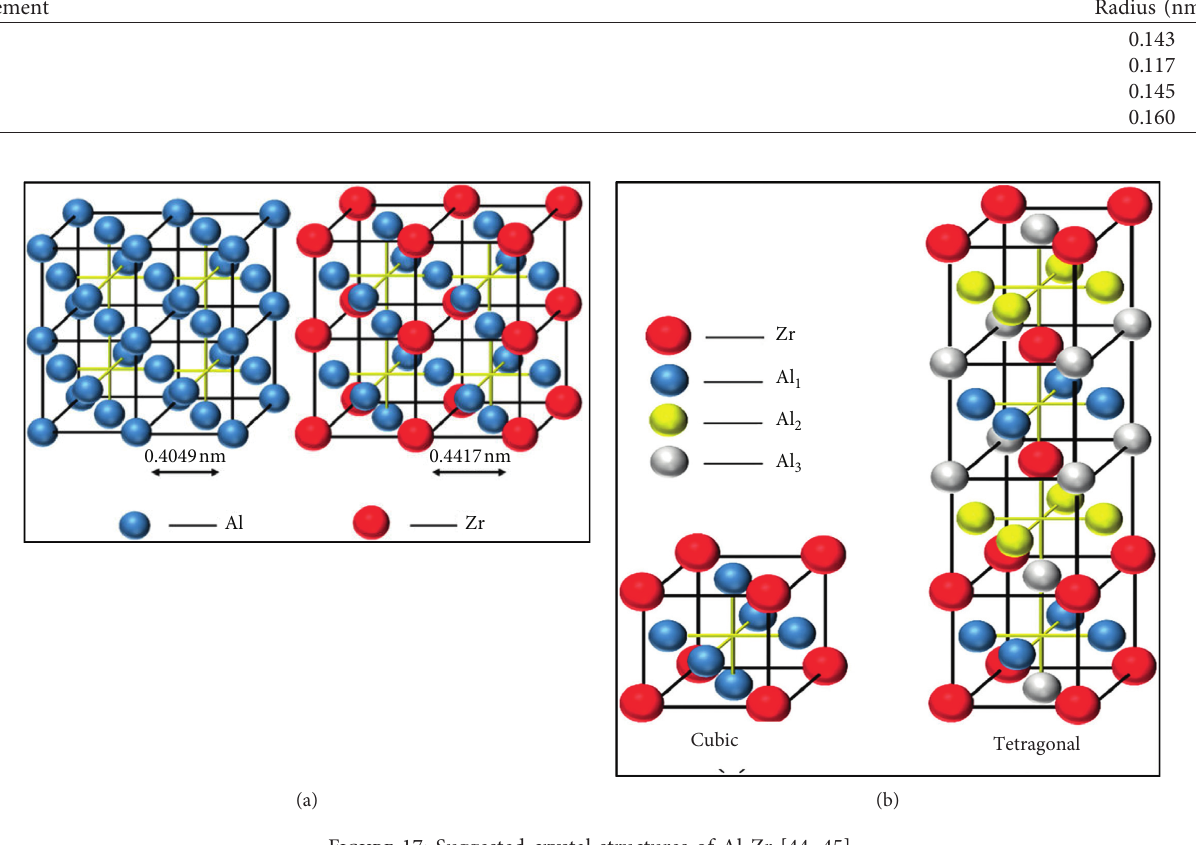
Figure 17: Suggested crystal structures of Al